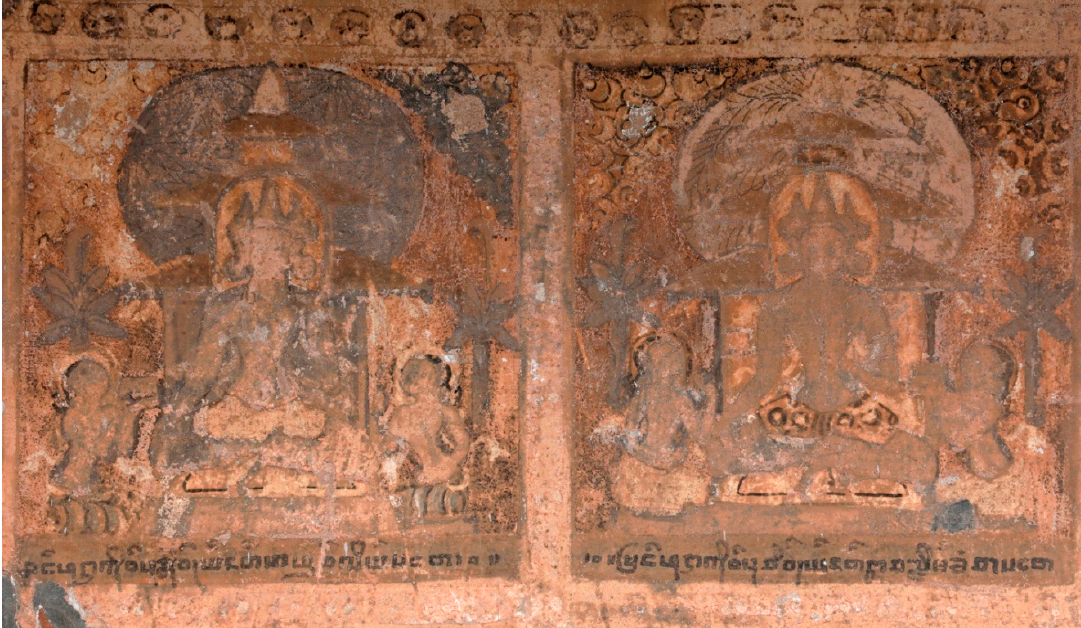
Figure 30. Pagan, Kutha, 13th century. Two vimanas allocated for animals.